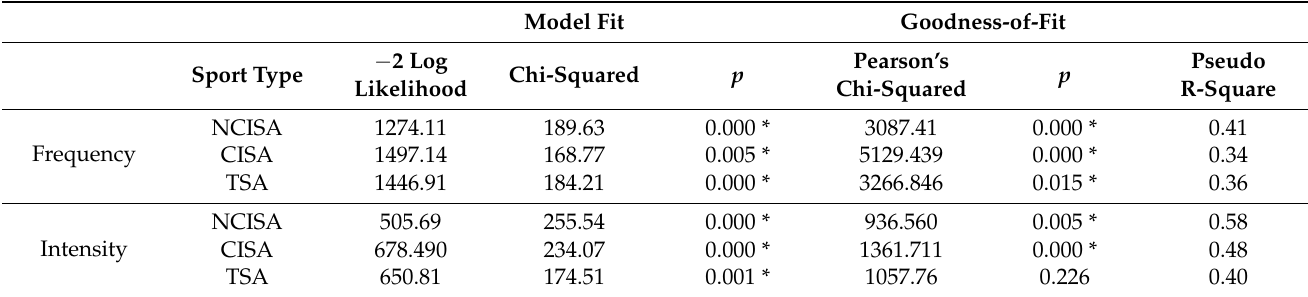
Table 4. Ordinal regression parameters of NCISA, CISA, and TSA during the COVID-19 pandemic. Model